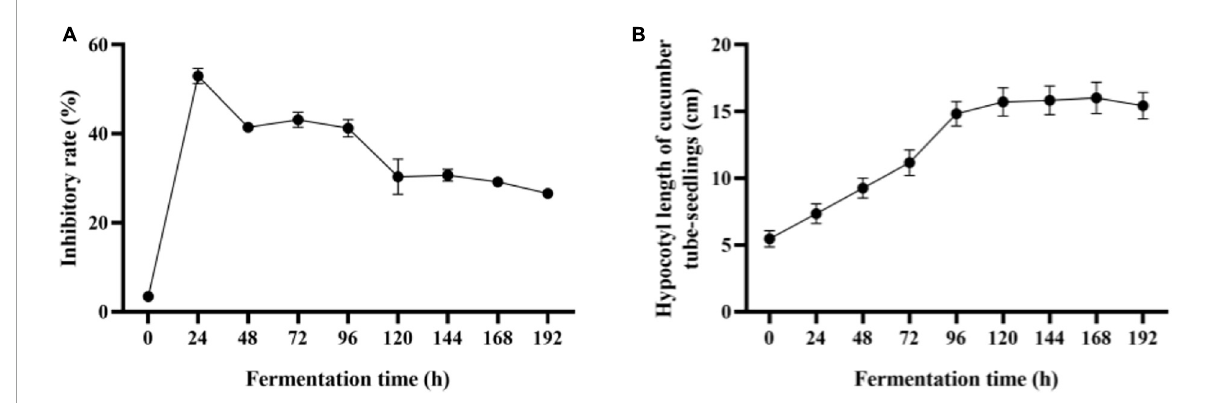
FIGURE3 Batch co-culture of Trichoderma composite in the bioreactor. (A) Inhibition effect of sterile filtrate of co-fermentation broth against F. oxysporum . (B) Growth-promoting effects (cucumber hypocotyl length) of co-fermentation broth. The experiments were done in quintuplicate. The error bars were represented in the graph; standard deviation and mean were determined.